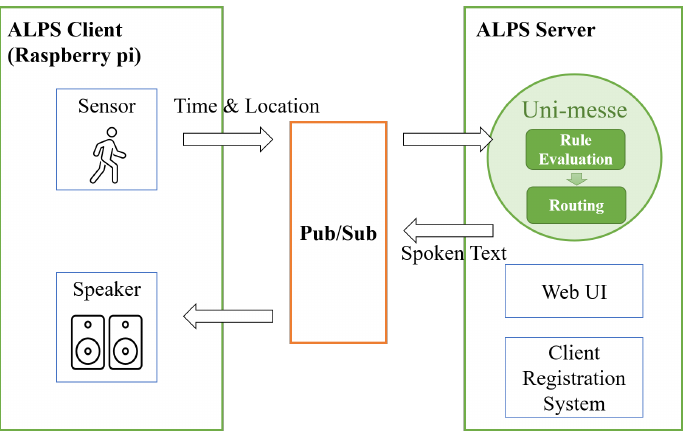
Figure 4. The new ALPS architecture with